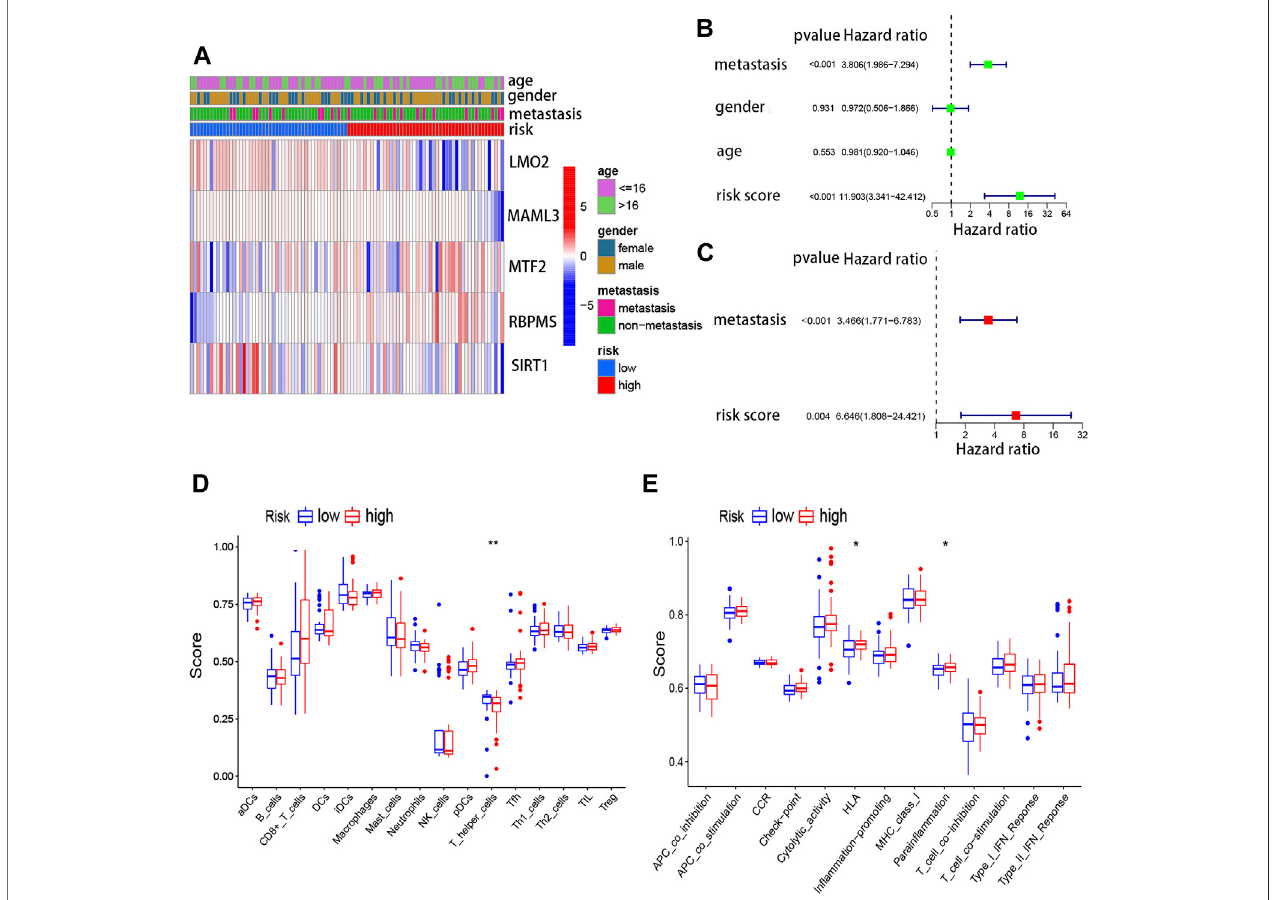
FIGURE5 | Risk score model and immune cells, aswell asimmune signaling pathways. (A) Expressions of fi vegenesin the riskmodel between high- and low-risk scores. (B) Univariate Cox regression analysis for the risk score based on TARGET. (C) Multivariate Cox regression analysis for the risk score based on TARGET. (D) Associationbetweenthe riskscoreand differentimmunecellsbasedon TARGET and GSE21257. (E) Association betweenthe riskscoreand differentimmunefeatures based on TARGET and GSE21257.